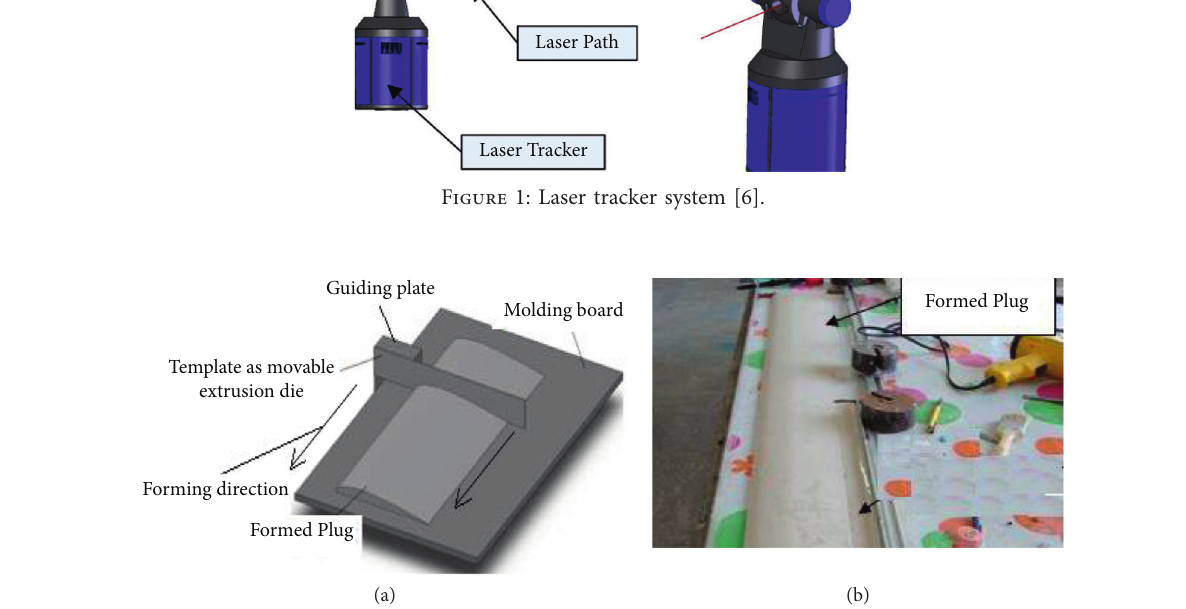
Figure 2: Schematic representation of plug forming process.